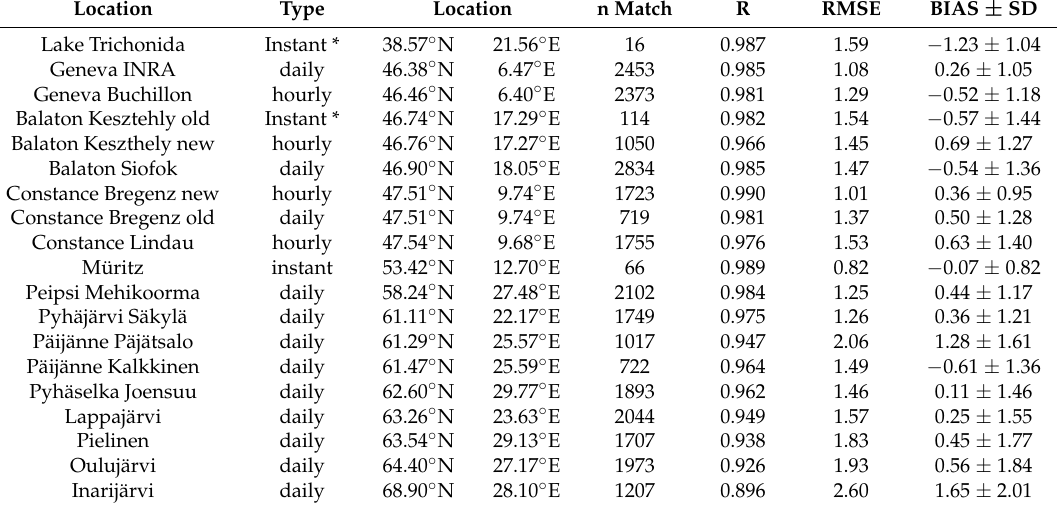
Table 4. Validation results for each in-situ station. The data is ordered by latitude from south to north. The measurement type describes the averaging of the in-situ measurement: daily averaged, hourly averaged, and instant measurements. Instant measurements are single measurements that were manually taken during measurement campaigns. As the exact timestamps for the instant measurements where not known at Lake Balaton (Kesztehly old) and Lake Trichonida, 12:00 local time is assumed. Location Type Location n Match R